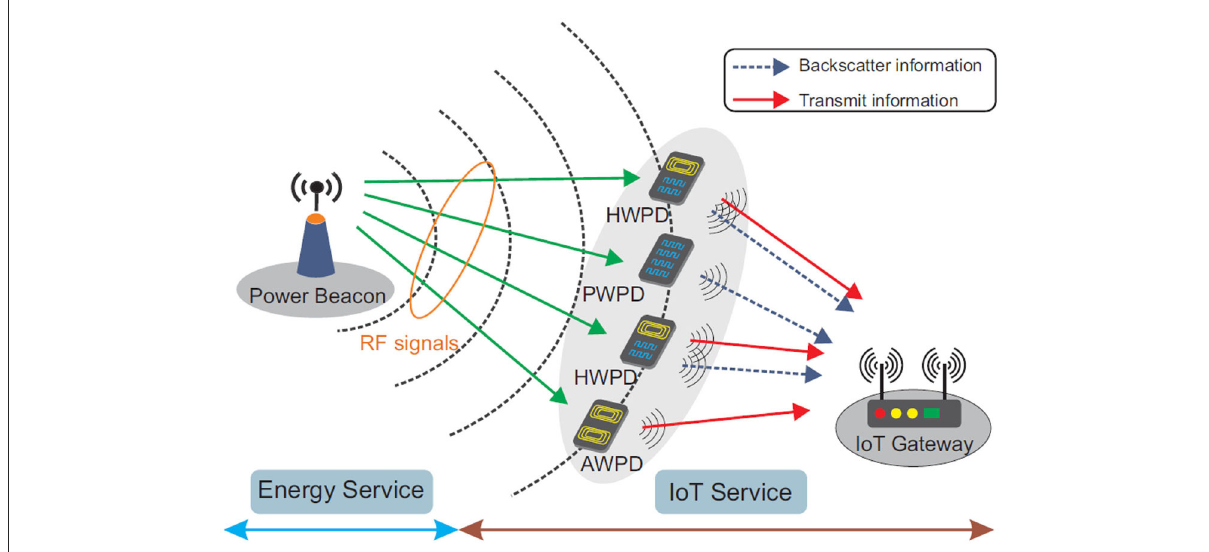
FIGURE12 Proposed model for energy trading for heterogeneous wireless power IoT networks (Nguyen et al., 2021).